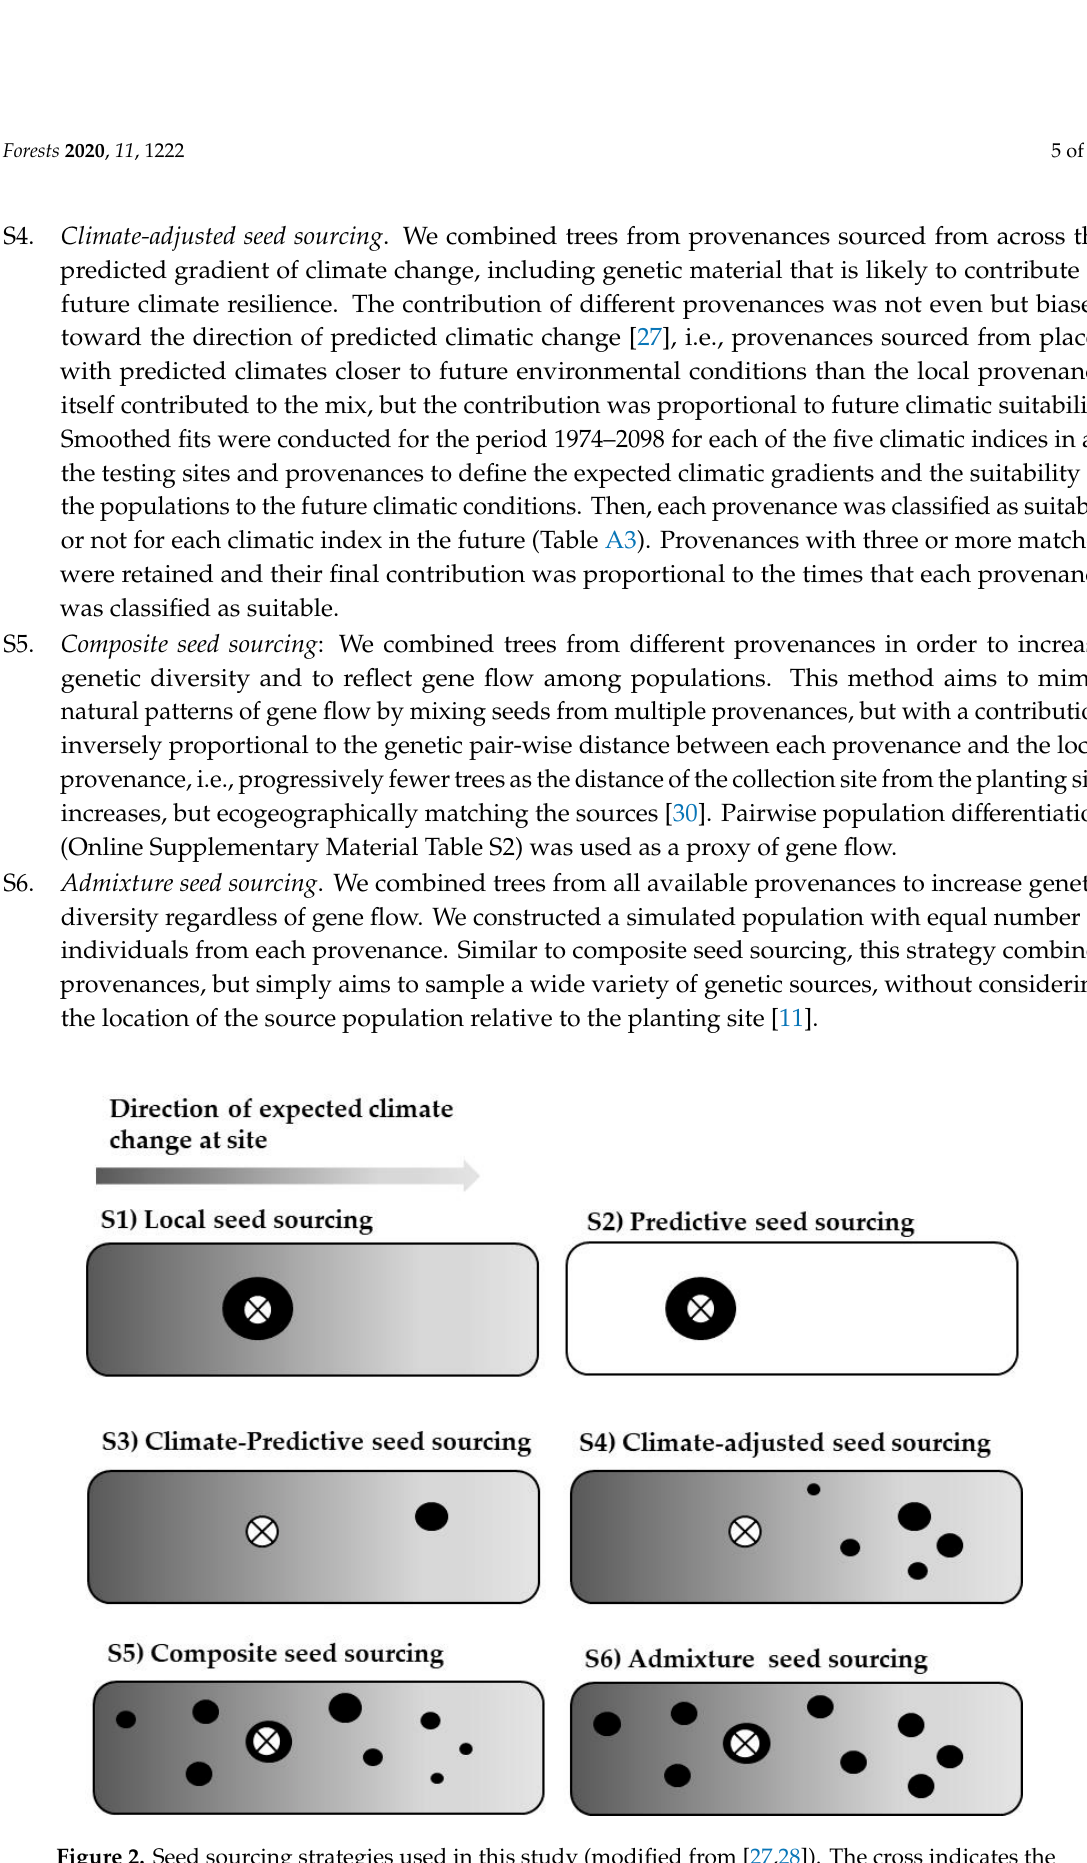
Figure 2. Seed sourcing strategies used in this study (modified from [27,28]). The cross indicates the site (provenance test) and the circles indicate the populations used as seed sources. The size of the circle indicates the contribution of each population to the seed sourcing strategy.